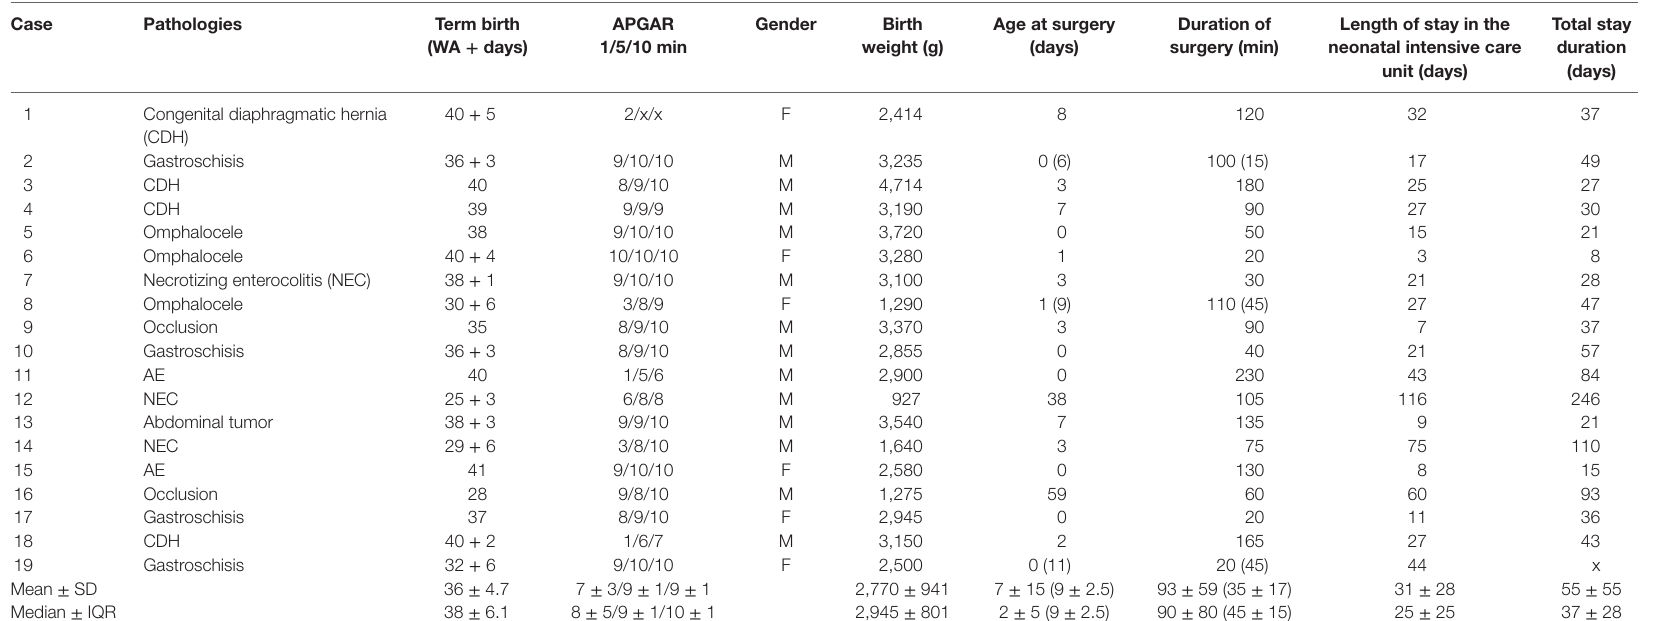
TaBle 1 | Population